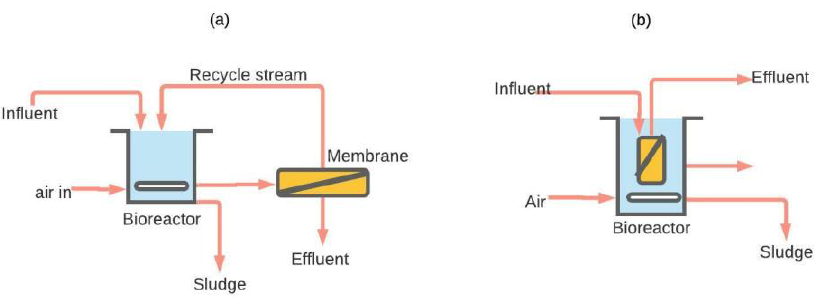
Figure 8. AnMBR configurations: ( a ) side stream configuration, ( b ) submerged configuration.